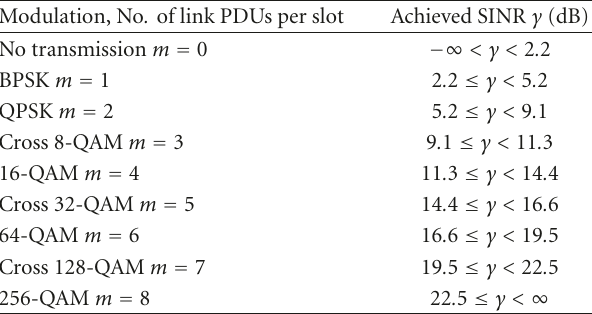
Table 2: Look up table for modulation